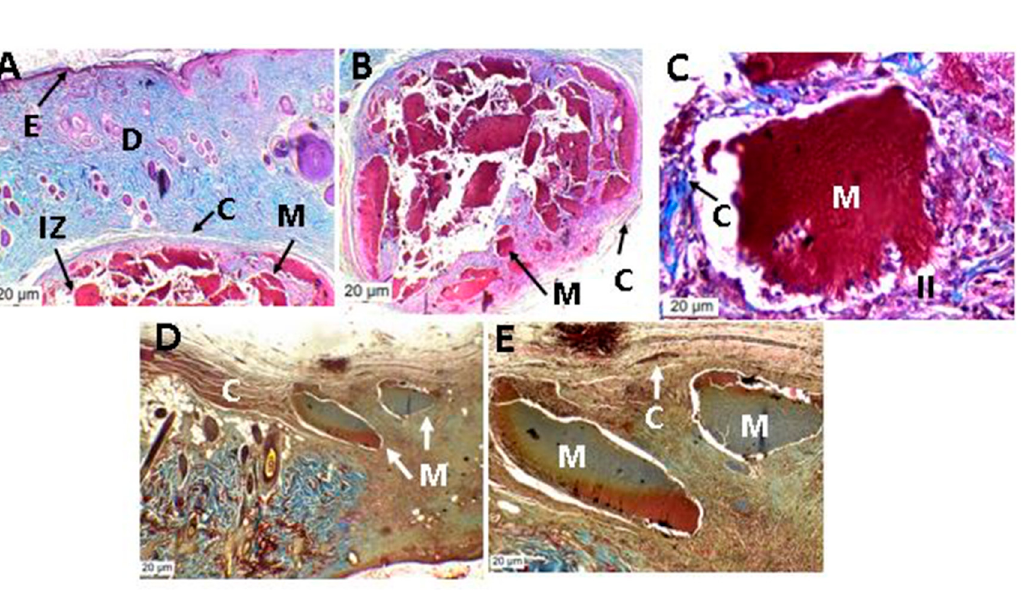
Figure 12. Histological analysis of experimental sample F4 (29.25 CS/70 PVA/0.75 ox-CNO). Magnifications are as follows: ( A ) 4×; ( B ) 10×; ( C ) 40×; ( D ) 4×; ( E ) 40×. E: epidermis; D: dermis; H: